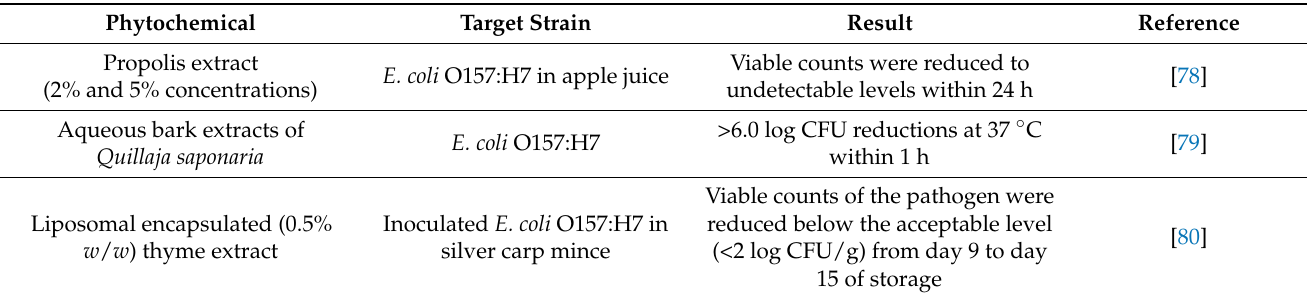
Table 2. Anti- E. coli O157:H7 activity of certain